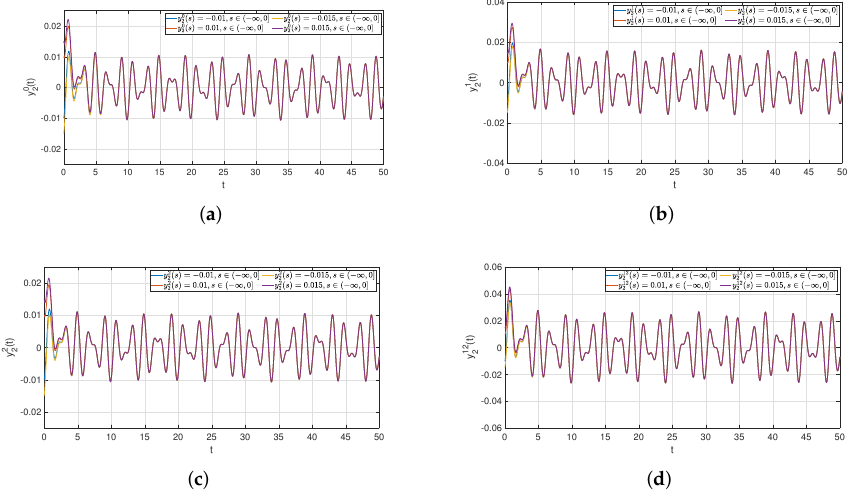
( t ) , y 2 ( t ) , y 12 ( t ) of system (5) with different initial values. ( a ) y 0 ( t ) , y 1 2 2 2 2 with different initial values; ( c ) y 2 2